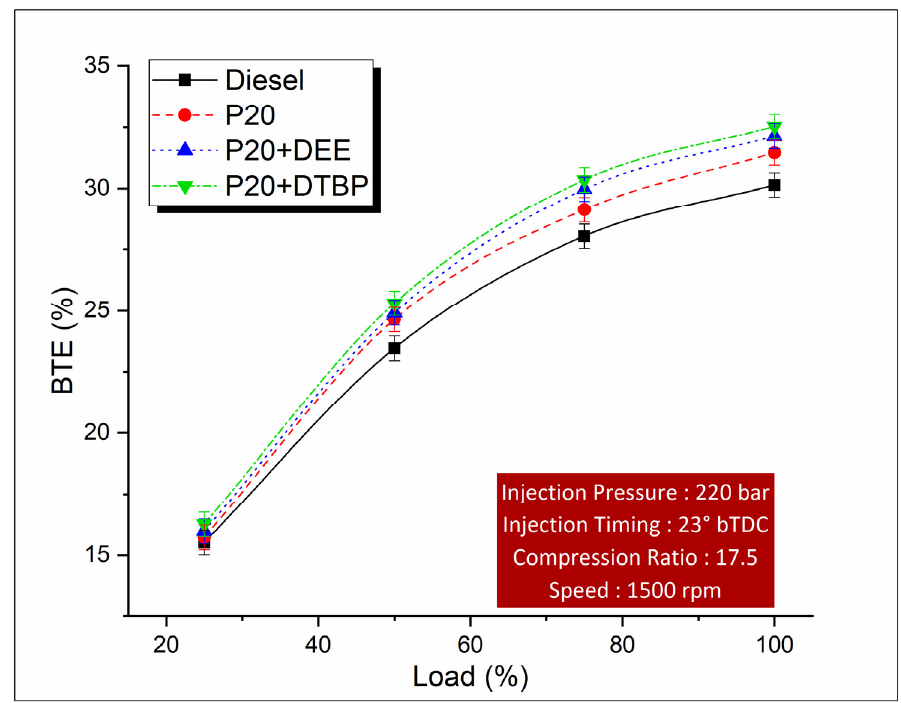
Figure 6. BTE variation for test fuel blends at different load